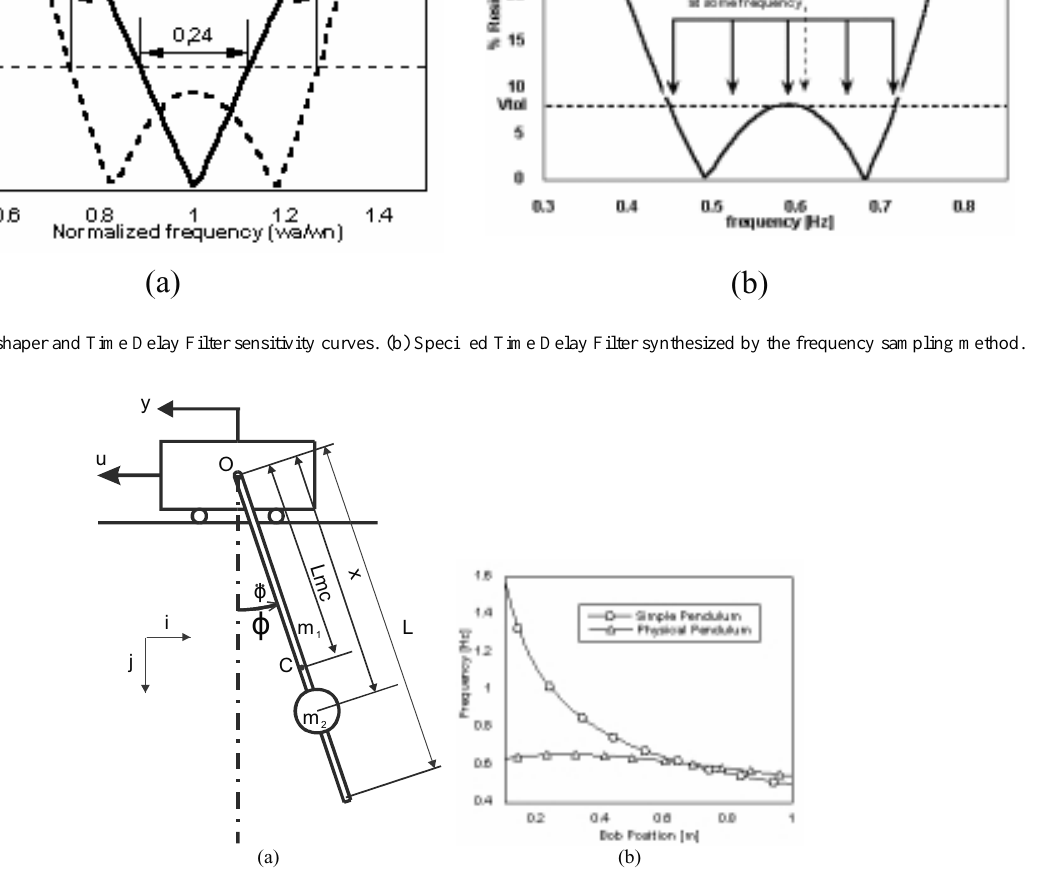
Fig. 5. (a) Bob-rod physical-Pendulum Overhead Crane. (b) Natural frequency as a function of bob position –x- for a simple and a physical pendulum. where ω s , the sampled frequency represent the frequency where the vibration is